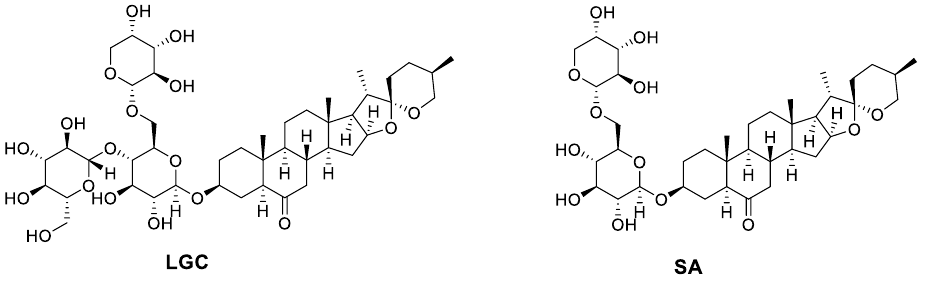
Figure 1. Chemical structures of LGC and SA.